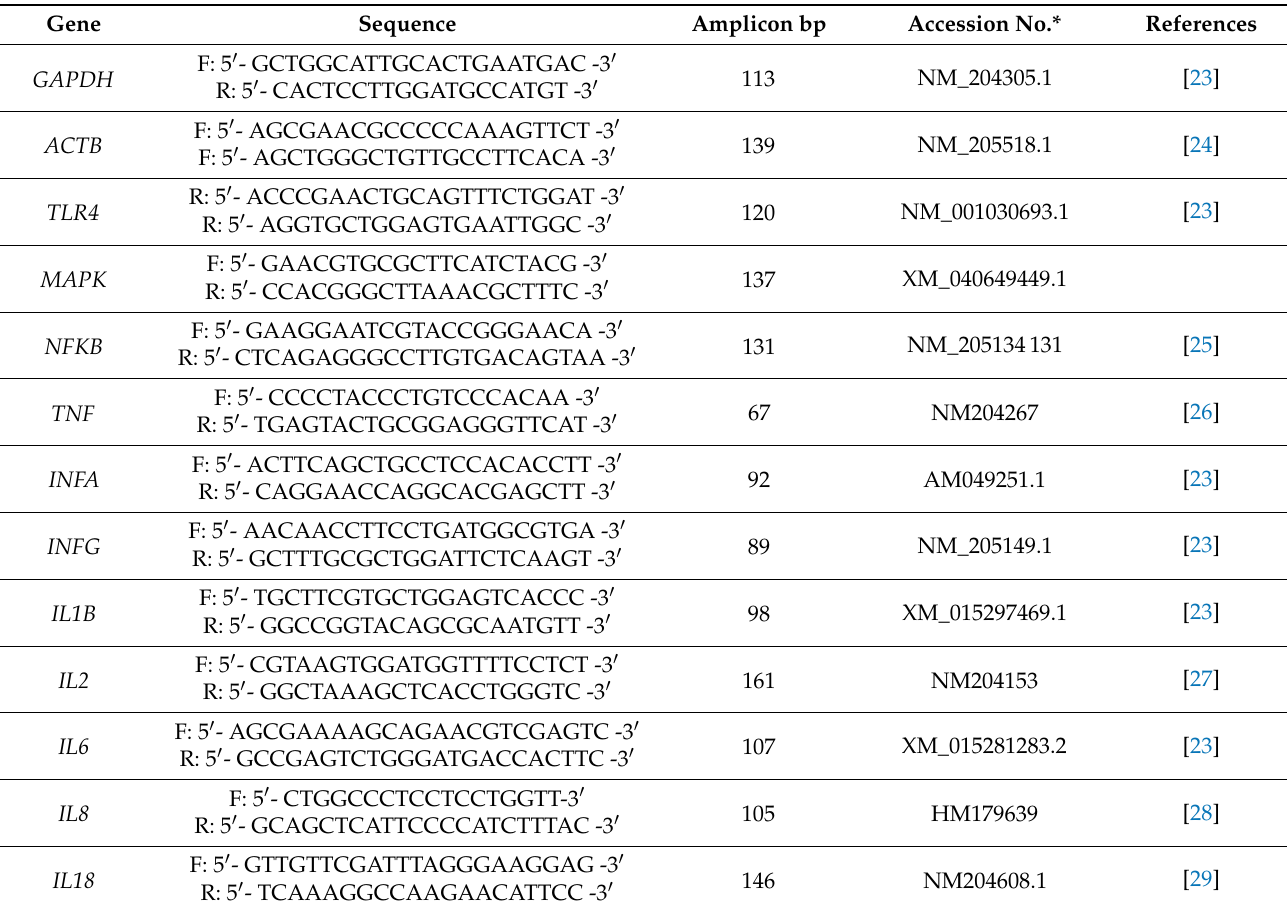
Table 1. Sequences and relative positions of primers for target genes used in real-time qPCR. Gene Sequence